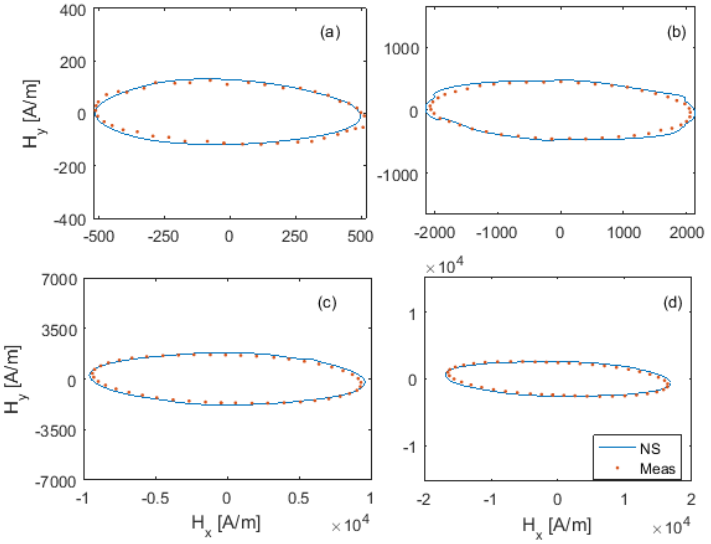
Figure 6. Comparison between simulated and measured trajectories of the H field relative to the elliptic loops with AR = 0.25 for the following values of the major half-axis: Bx = 10 mT ( a ), Bx = 100 mT ( b ), Bx = 400 mT ( c ), and Bx = 600 mT ( d ).